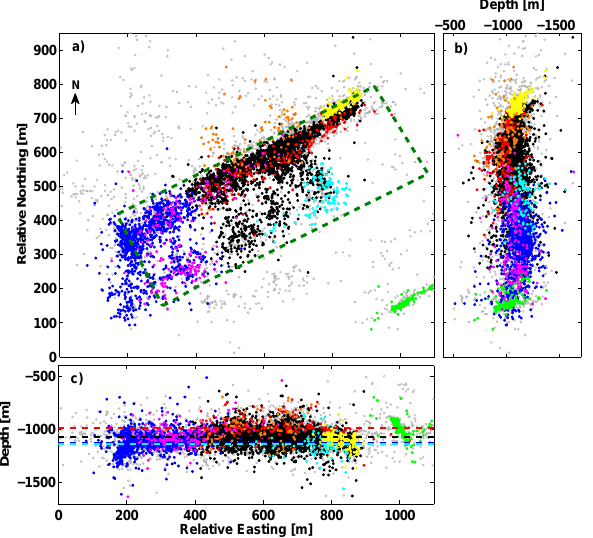
Fig. 10. (a) Absolute and (b) cumulative frequency magnitude dis- tributions of the eight largest clusters found by visual extraction from the sorted network matrices. Colour coding is the same as in Fig. 7 except for the yellow cluster which is depicted in brown here for better visibility. (c) Absolute and (d) cumulative frequency mag- nitude distribution of the eight largest clusters found with the SL algorithm. Vertical broken grey line indicates the approximate com- pleteness magnitude of the entire catalogue. Also indicated in (b) and (d) are the b values for those frequency magnitude distributions exhibiting a GFT residual of less than 10% and having a complete- ness magnitude comparable or better than the entire